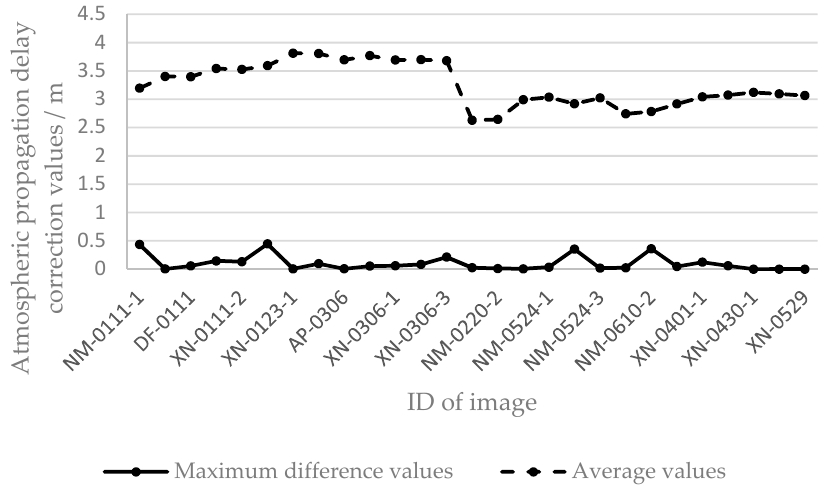
Figure 3. Variation in correction values in the range direction.